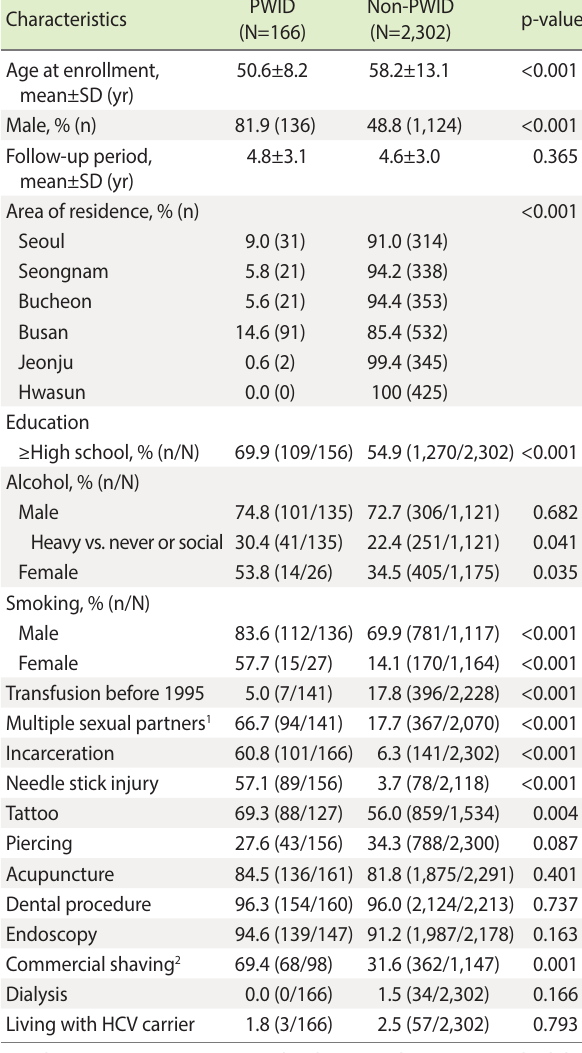
Table 1. Comparison of demographic characteristics and exposure to risk factors for HCV infection according to injection drug use